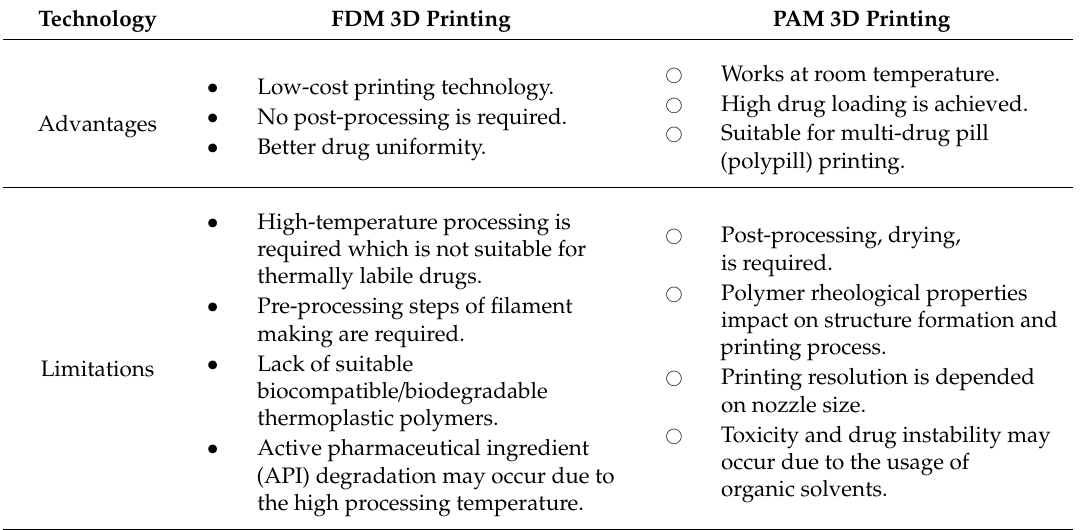
Table 1. Comparison of FDM and PAM 3D printing